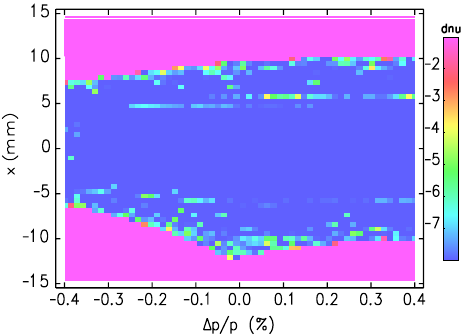
FIG. 7. Frequency map in the ( x (cid:1) (cid:1) p=p ) phase space. The color reflects the tune change in terms of the tune diffusion d ð (cid:1) (cid:8) 2 þ (cid:1) (cid:8) 2 Þ . defined as d (cid:2) log x y 10